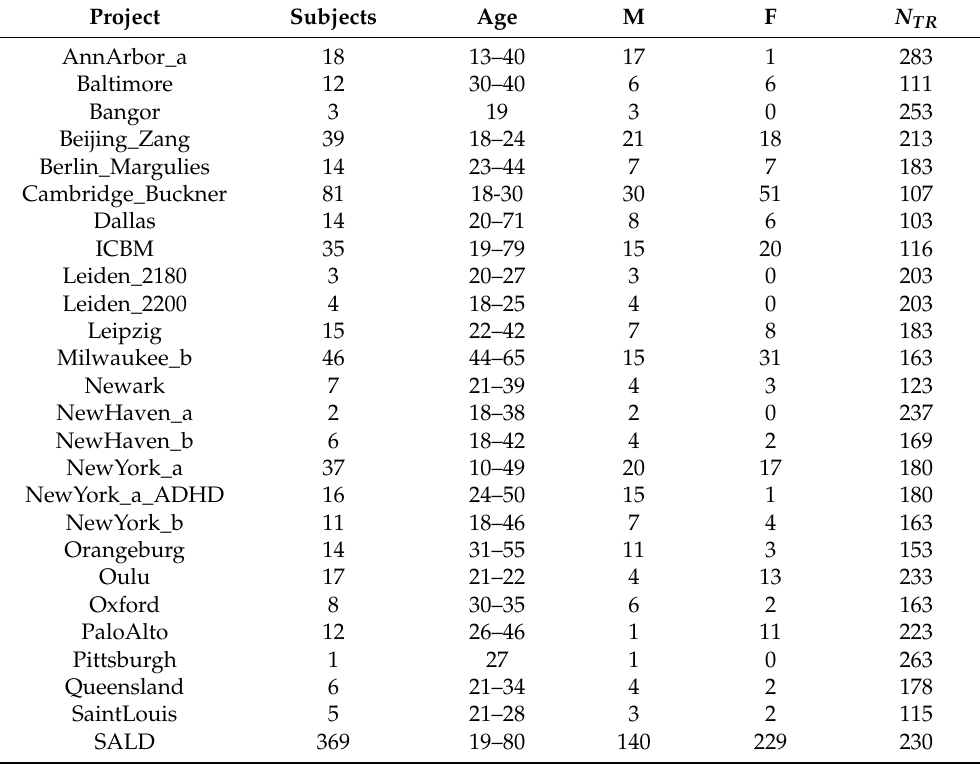
Table 1. Detailed information of data collection. (M: Male; F: Female; N TR : the number of repetition time